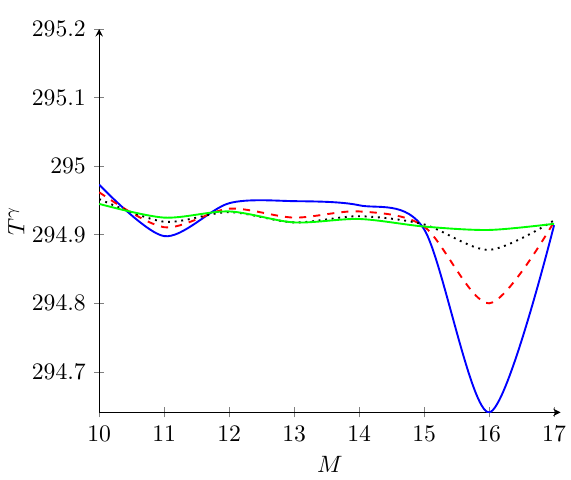
Figure 3 . The higher derivative correction T (cid:13) for to the temperature, computed on intervals [0 : 1 ; k ] for di(cid:11)erent values of M (shown in a smoothed plot). The solid blue line shows the results for k = 0 : 975, the dashed red line corresponds k = 0 : 98, the dotted black line corresponds to k = 0 : 985 and the solid green line corresponds to k = 0 : 99. The metric was extrapolated to u = 1. In (cid:12)gure 3 we display the results for the correction factor to the temperature obtained by calculations on intervals [0 : 1 ; k ], we extrapolated the resulting coupling corrections to the metric to u =